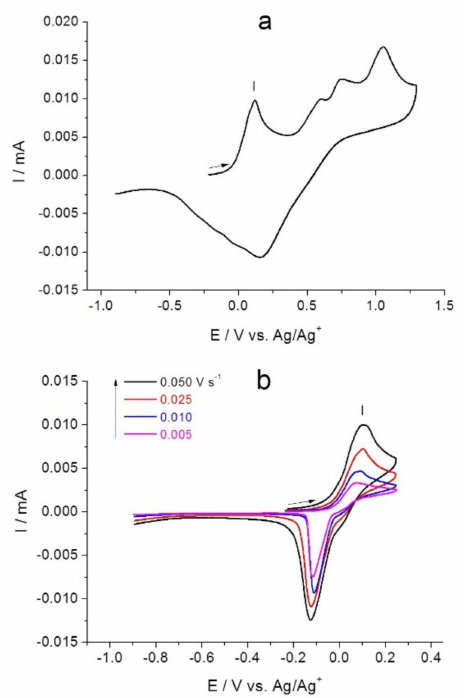
Figure 4. Cyclic voltammograms of a glassy carbon electrode (0.07 cm 2 ) in 0.001 mol L − 1 solution of [NiAmben] in 0.05 M Et 4 NBF 4 /DCE: ( a ) between − 0.9 and 1.3 V at a scan rate of 0.05 V s − 1 ; ( b ) between − 0.9 and 0.25 V at 0.005–0.05 V s − 1 scan